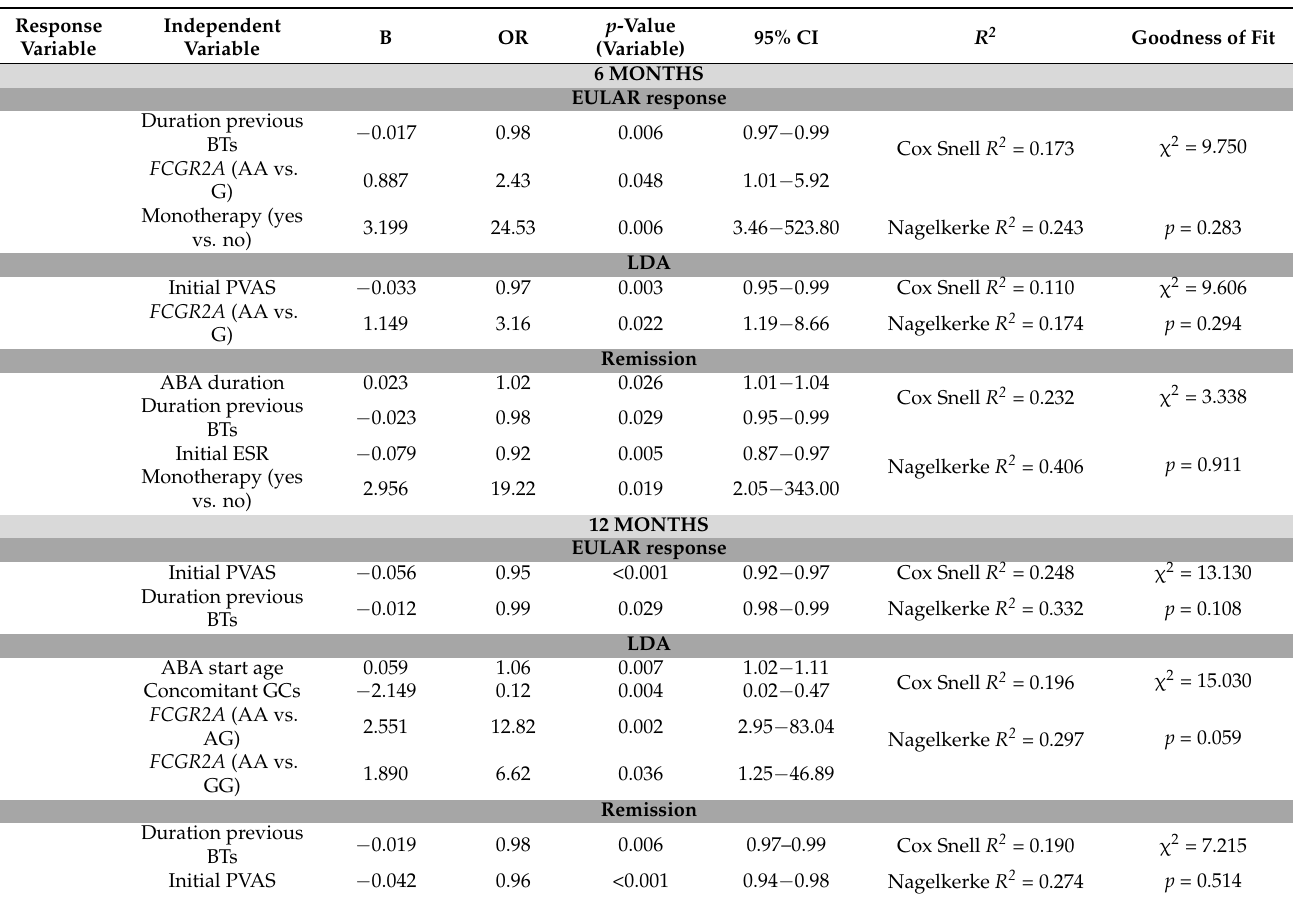
Table 3. Predictors of response at 6 and 12 months of treatment with abatacept in rheumatoid arthritis patients (multivari- ate